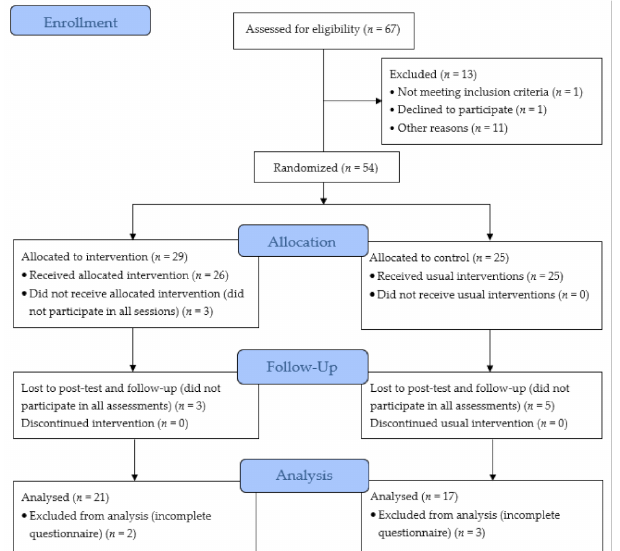
Figure 1. Participants’ flow diagram through the phases of the quasi-cluster randomized controlled